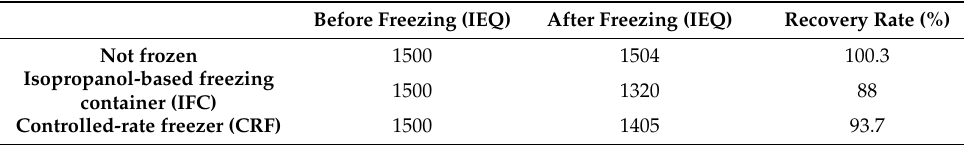
Table 3. Islet equivalent (IEQ) of islet cells after cryopreservation and thawing. Before Freezing (IEQ) After Freezing